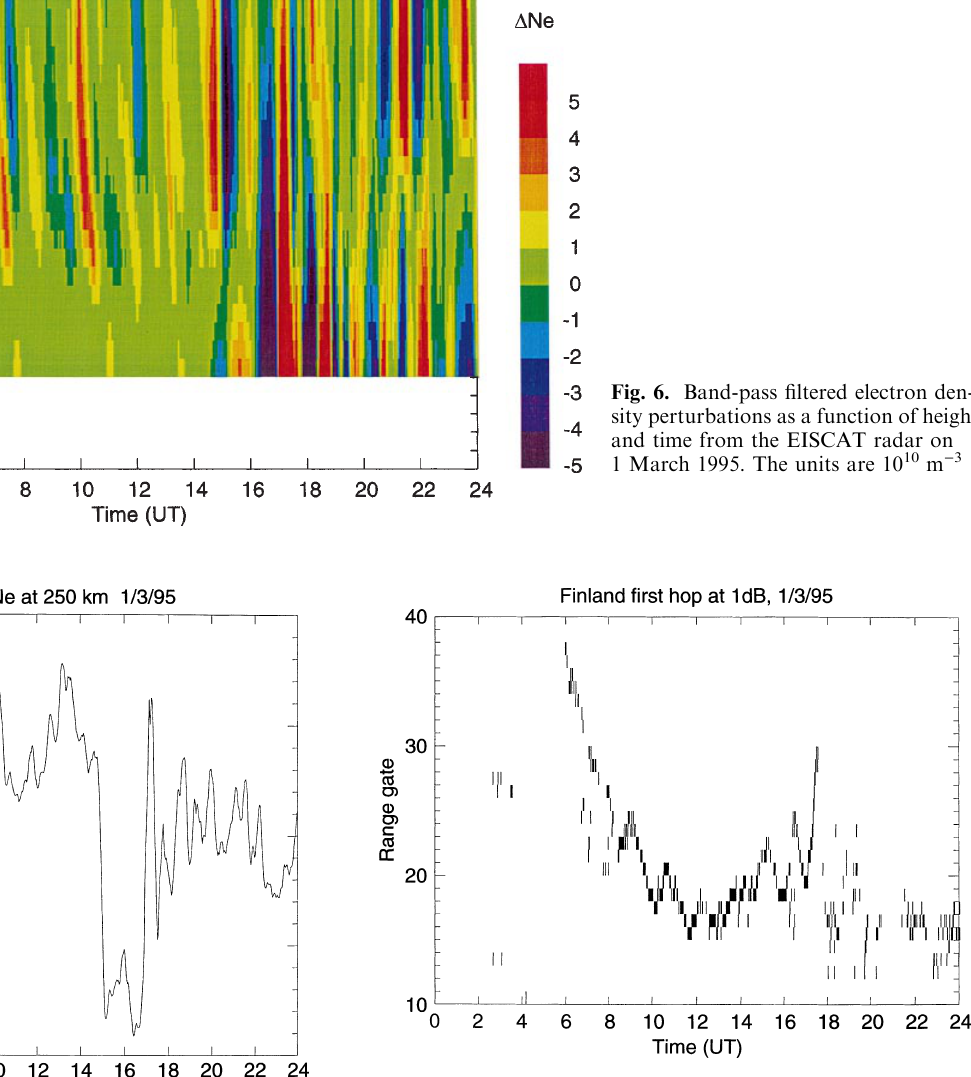
Fig. 8. Filtered first return data from CUTLASS Finland on 1 March, 1995 with the timing adjusted to allow for propagation for the Tromsø site assuming a line-of-sight phase velocity of 250 ms )